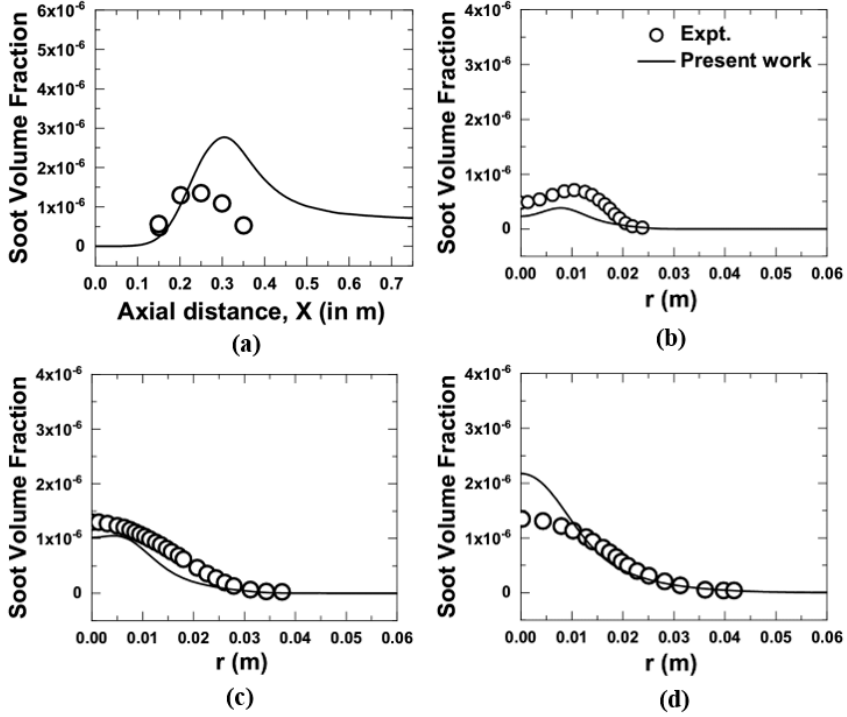
Figure 6. Comparison of soot volume fractions obtained from the present numerical model with the measurements [10] at 3 atm; ( a ) axial variation, and ( b – d ) radial variation at an axial location of 0.15 m, 0.2 m, and 0.25 m, respectively.